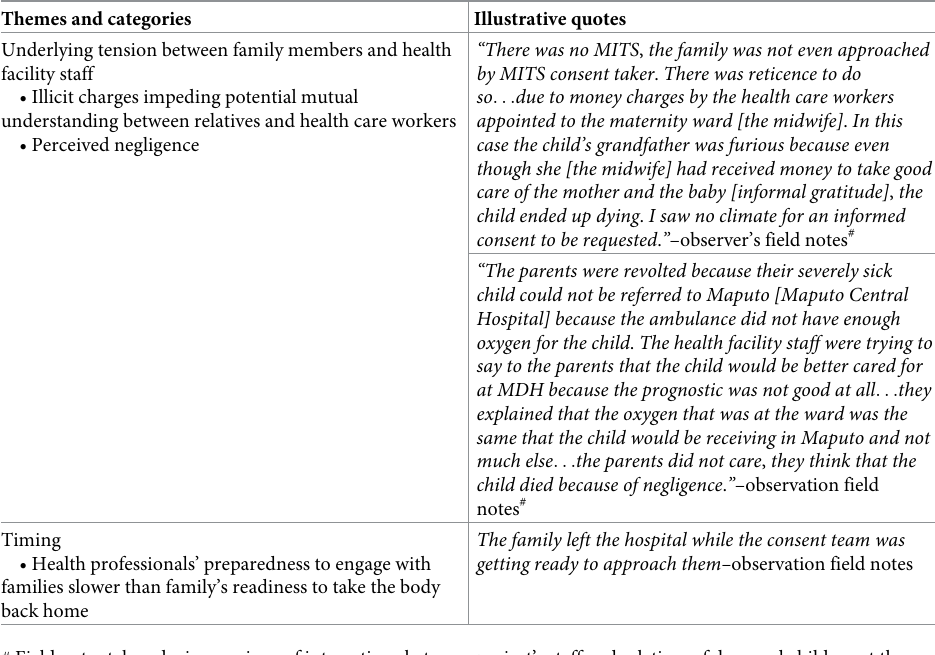
Table 4. Barriers for health professionals to approach family members to request consent to MITS.